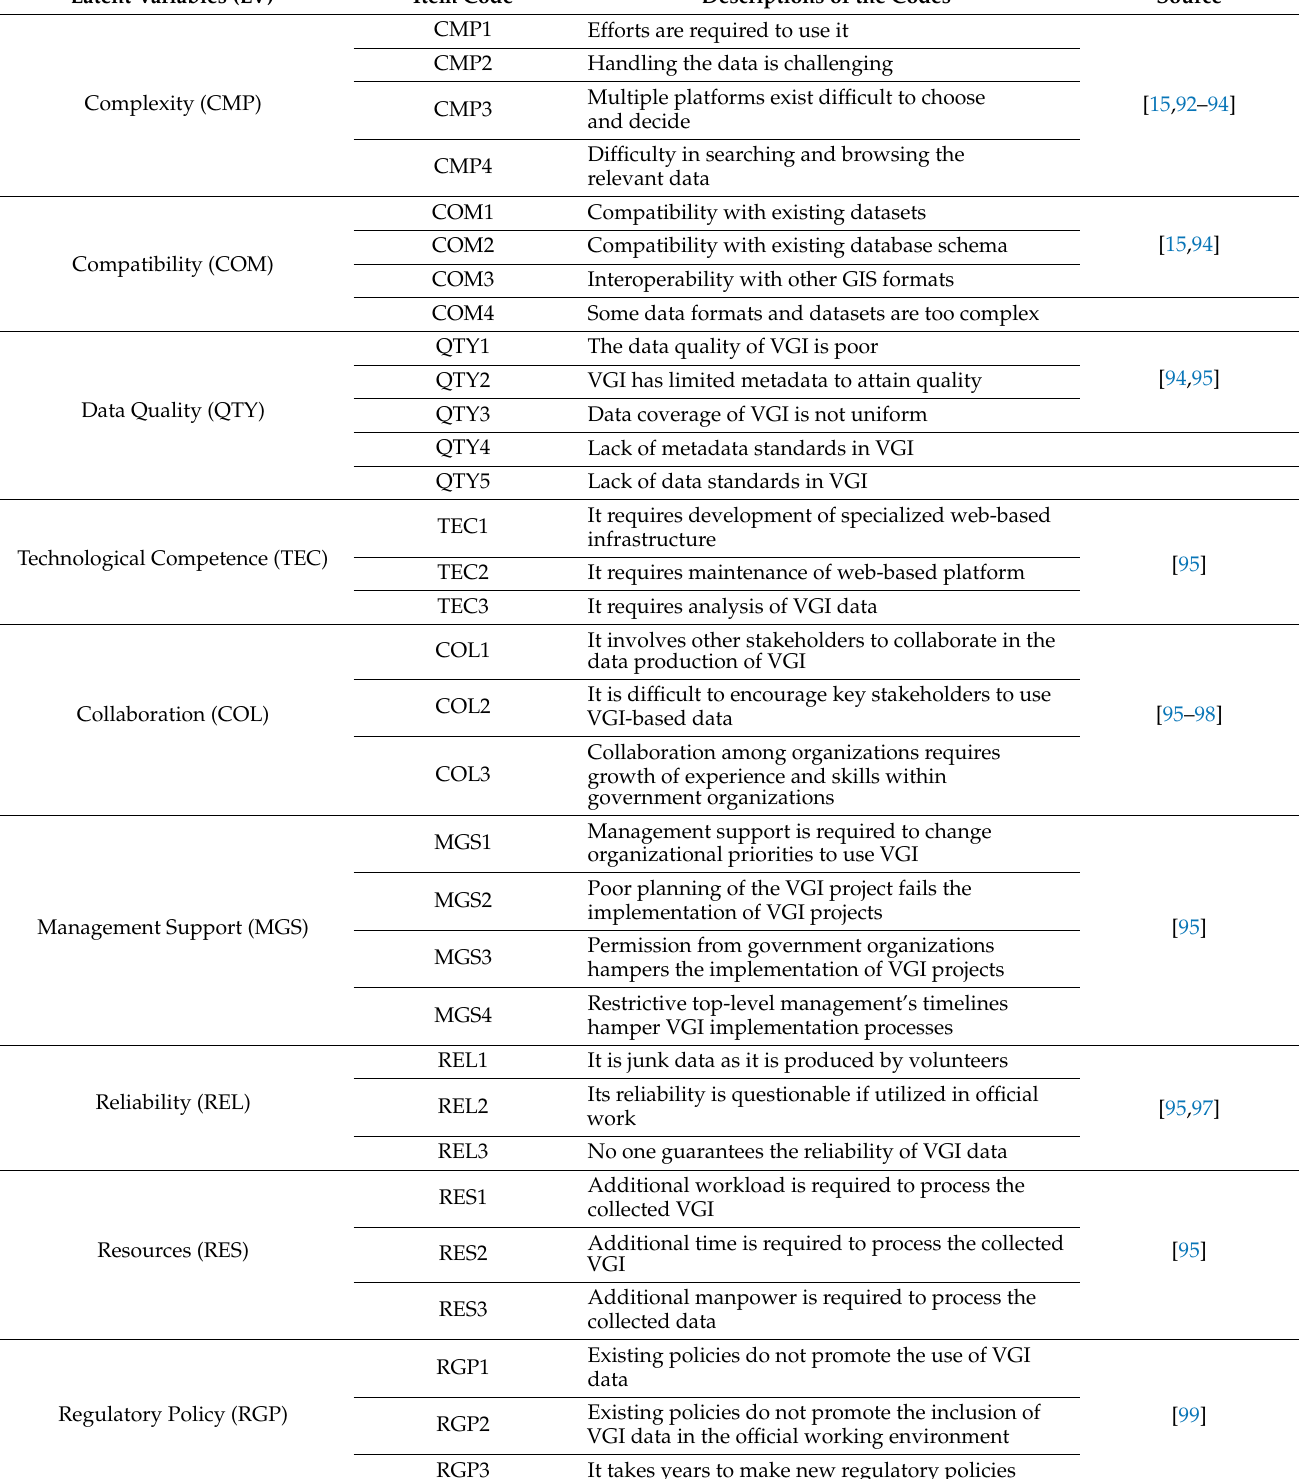
Table 1. Detail of latent variables and description of